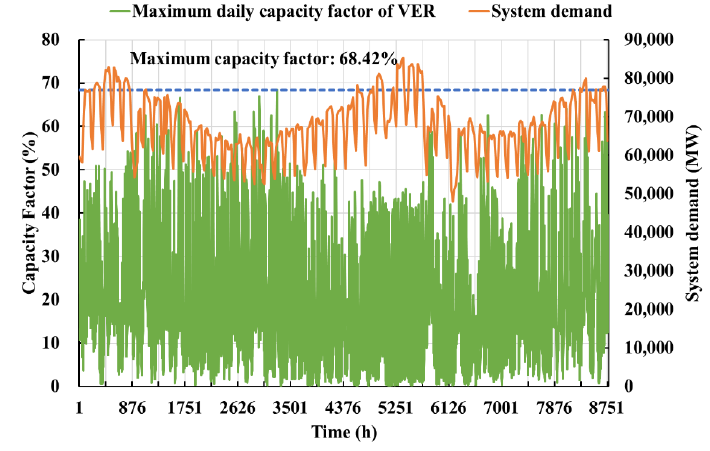
Figure 6. Generation characteristics of variable energy resource (VER)-based on daily output char- acteristic during a year.